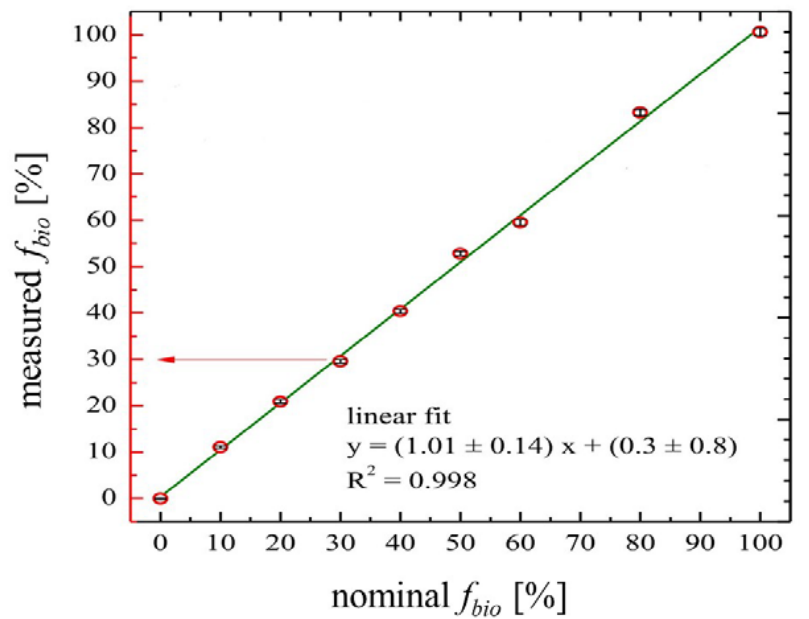
Figure 3. Measured vs. actual vegetable oil content in fossil fuel (source: [45]).